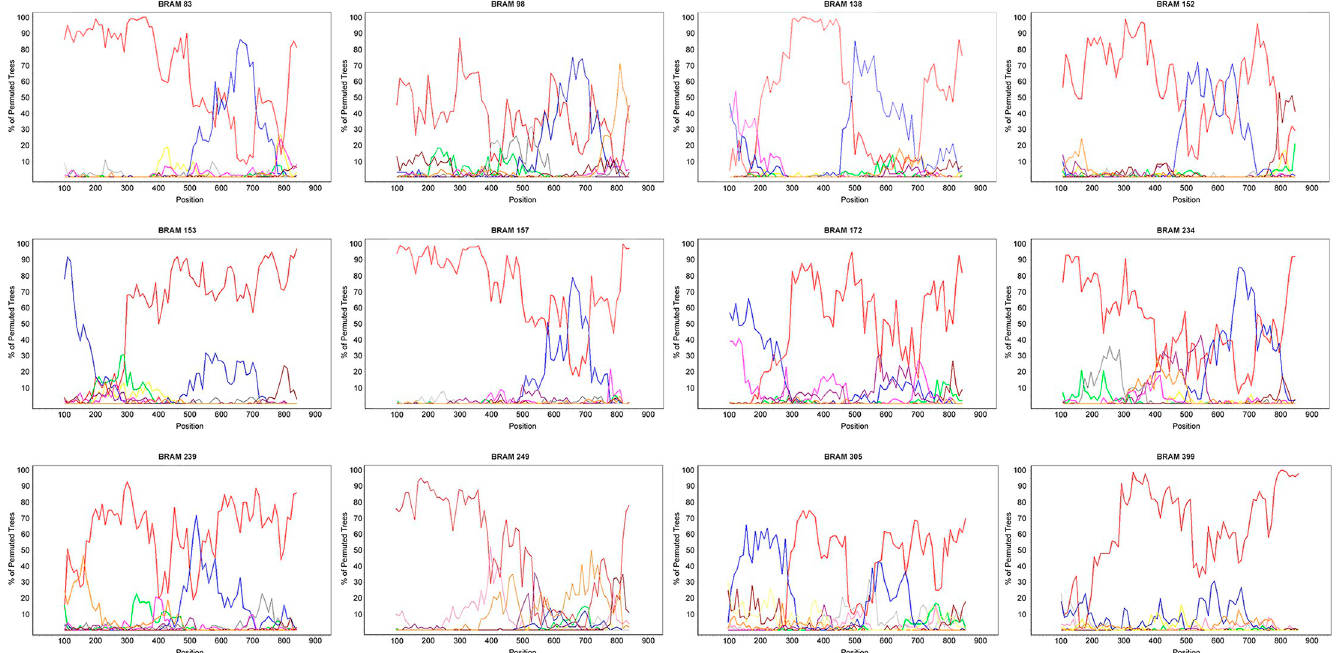
Fig 4. Bootscanning analyses of HIV-1 pol sequences of 12 BF1 recombinant viruses detected in blood donors from Northern Brazil. HIV-1 subtypes are indicated by different colors, Subtype A: yellow, Subtype B: red, Subtype C: green, Subtype D: pink, Subtype F1: blue, Subtype G: purple, Subtype H: gray, Subtype J: brown, Subtype K: orange. SIMPLOT 3.5.1 software was employed and recombination breakpoints were estimated using 200 bp sliding window, advanced in 20 bp steps size increments, 1000 replicates.